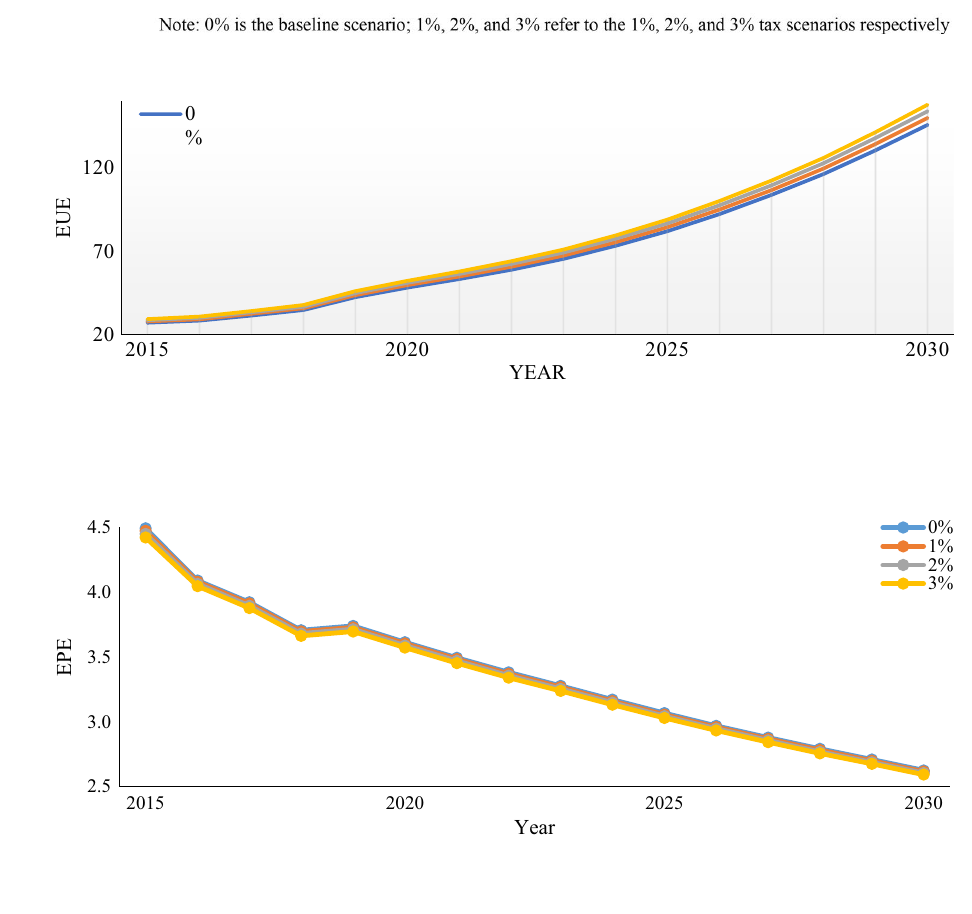
Fig. 12 The EPE in the base- line and tax